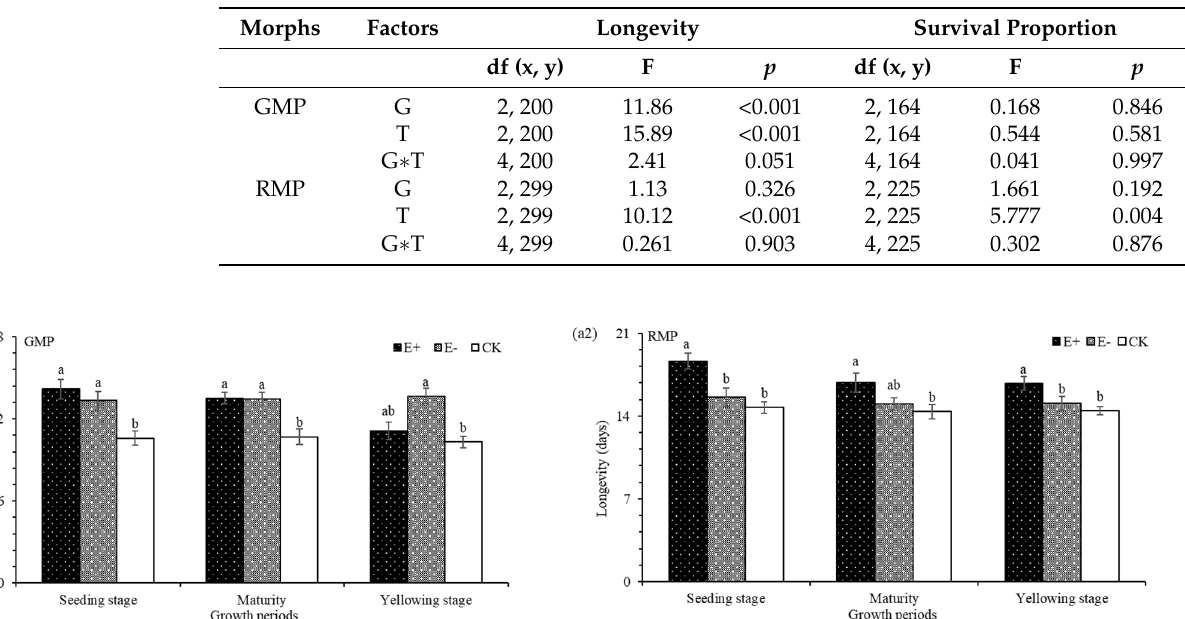
Figure 3. Developmental duration, weight difference and mean relative growth rate in green color morphs of pea aphids (GMP) and red color morphs of pea aphids (RMP) of Achnatherum inebrians with aqueous extracts of different growth periods ( a1 , a2 , b1 , b2 , c1 and c2 ). E+, endophyte-infected A. inebrians ; E − , endophyte-free A. inebrians ; CK, control. Dif- ferent capital letters indicate that there are significant differences between different growth periods, and different small letters indicate that there are significant differences between different treatments ( p < 0.05).